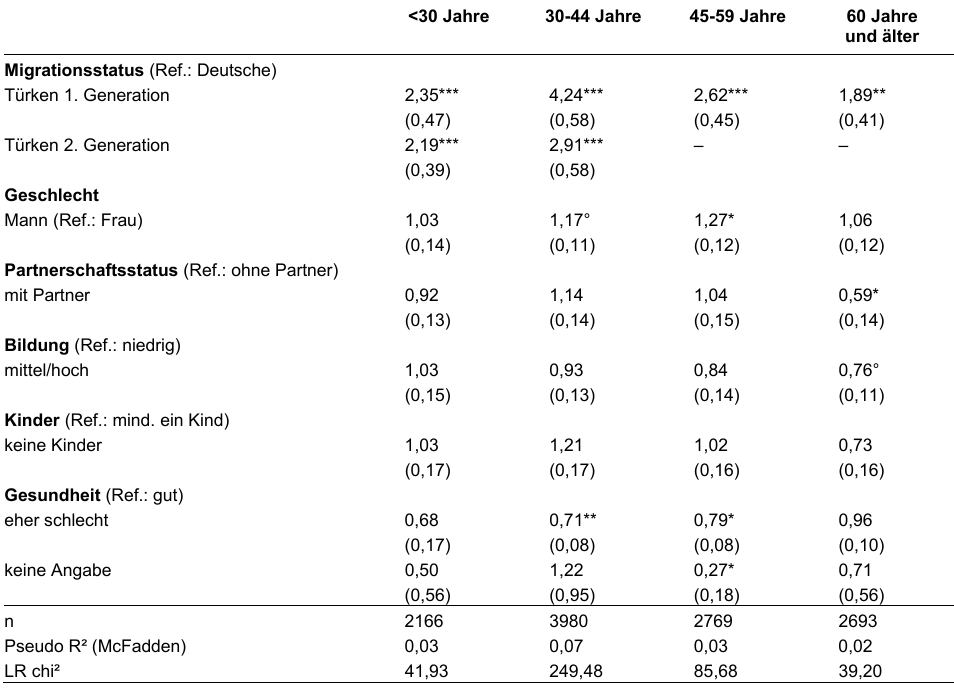
Tabelle 4a : Logistische Regression (OR) zur Zustimmung hinsichtlich der abhängigen Variable „Verantwortung übernehmen“ nach Alter <30 Jahre 30-44 Jahre 45-59